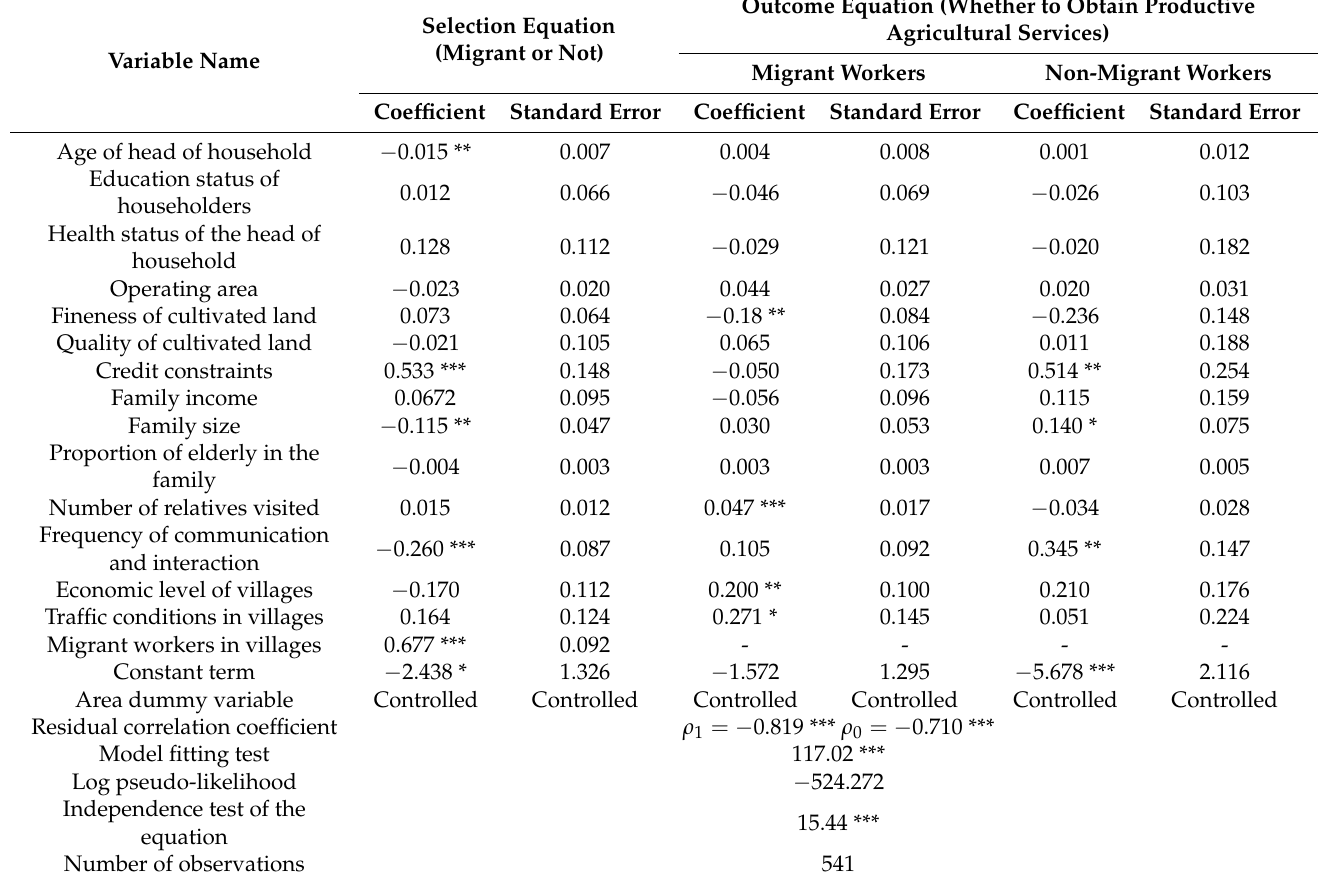
Table 1. Regression results of the impact of migrant workers on farmers’ access to productive agricultural